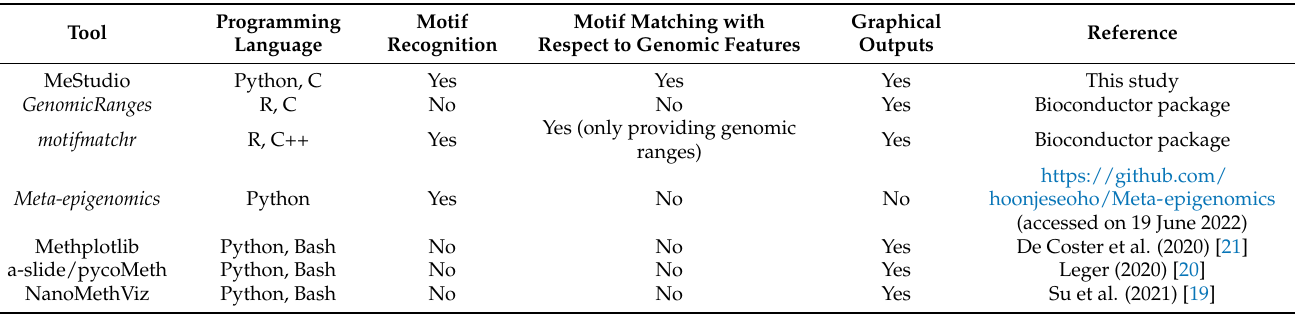
Table 1. MeStudio features compared to existing